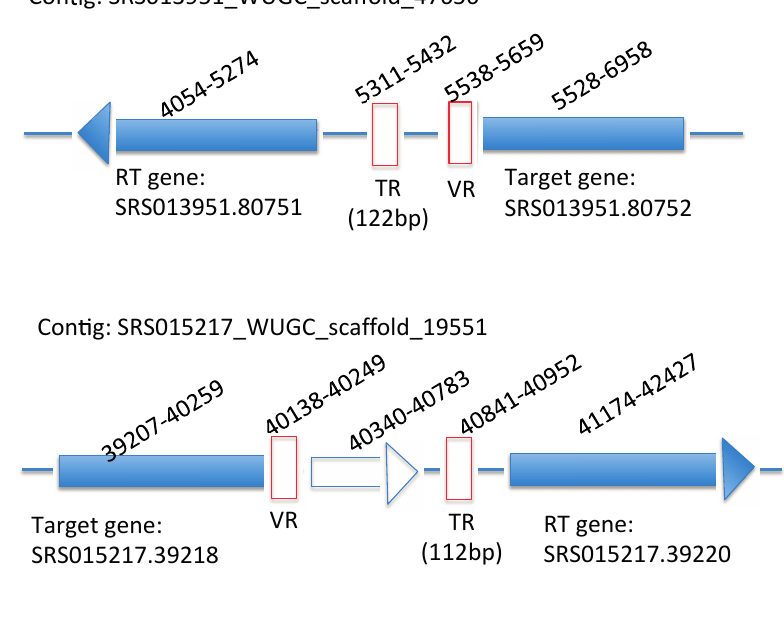
Green: reference genomes Blue : human Figure 3. Diagrams of two new DGR systems identified from the human microbiome project (HMP) datasets. Note that the RT genes encoded in these contigs were annotated with unknown functions in the human microbiome project (HMP) annotations.